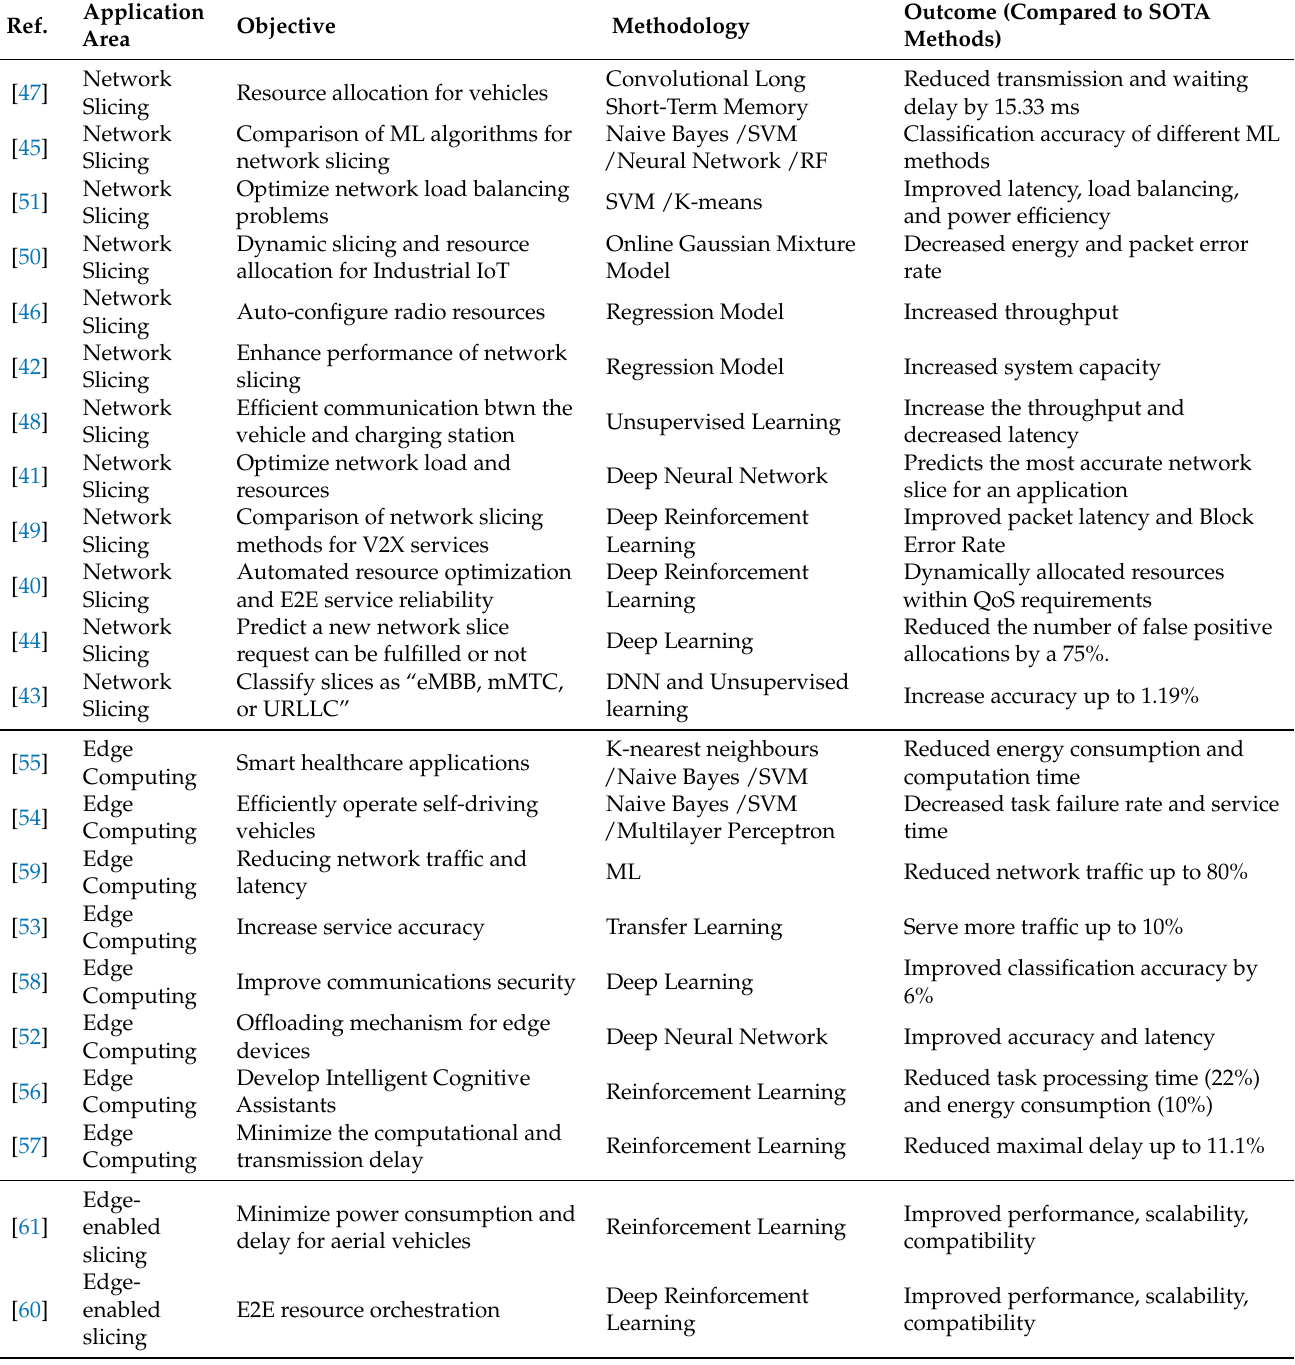
Table 3. Overview of studies that combine ML, network slicing, and edge computing techniques mentioned in Section